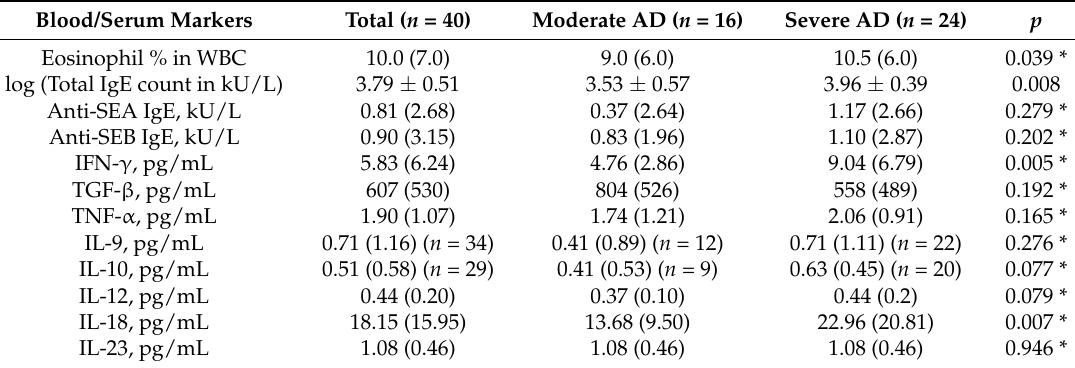
Table 2. Concentrations of seromarkers in patients with moderate and severe